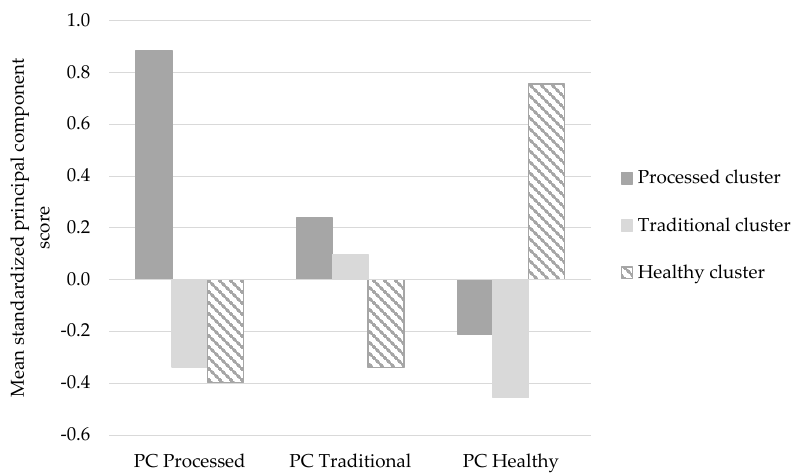
Figure 1. Mean standardized principal component scores for each cluster.